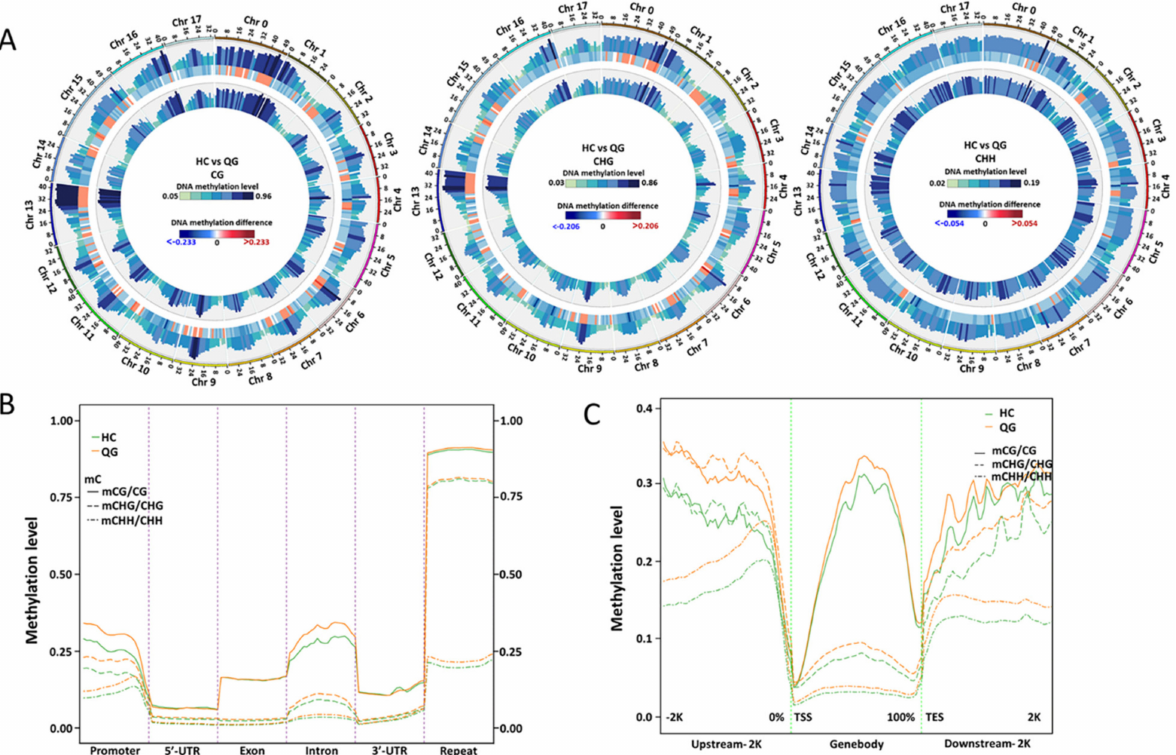
Figure 2. Comparison of the methylation in the CG, CHG, and CHH contexts in various genomic regions between ‘HC’ and ‘QG’ mature fruits. ( A ) Circos plots comparing the DNA methylation levels between ‘HC’ and ‘QG’ mature fruits. ( B ) Comparison of the DNA methylation patterns in various genomic regions between the mature fruits of ‘HC’ (green lines) and ‘QG’ (orange lines). ( C ) Comparison of the methylation levels in the upstream or downstream regions and gene bodies between the mature fruits of ‘HC’ (green lines) and ‘QG’ (orange lines). Solid lines, mCG; dash lines, mCHG; mixed line, mCHH. TSS, transcriptional start site; TES, transcriptional end